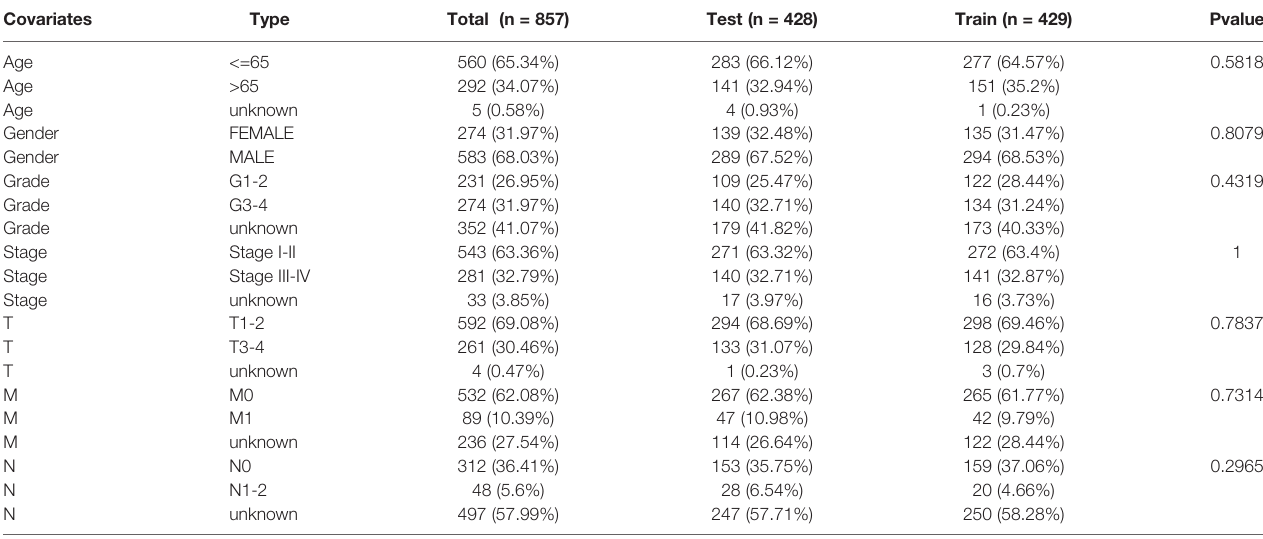
TABLE 1 | Clinicopathological information of the patients with RCC in TCGA cohort.